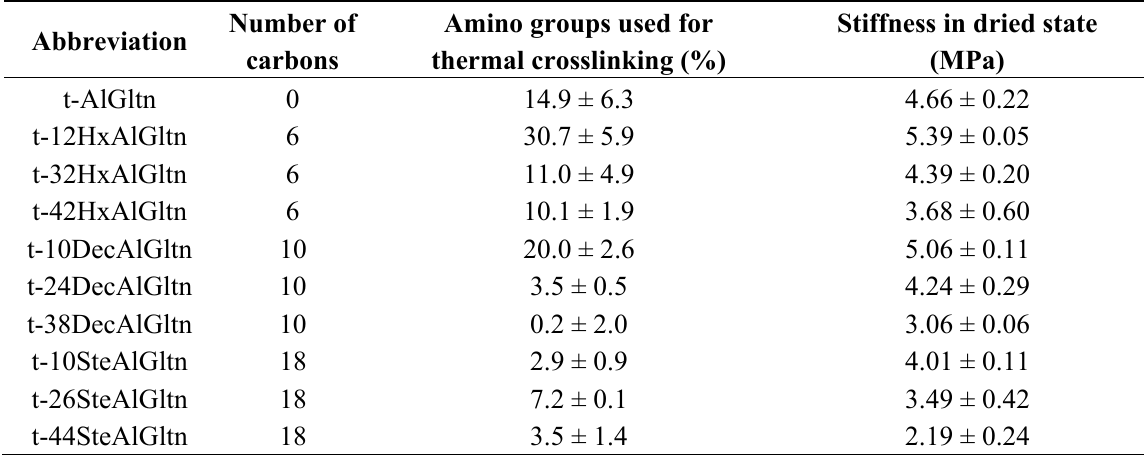
Table 2. T-hm-AlGltns with various modification